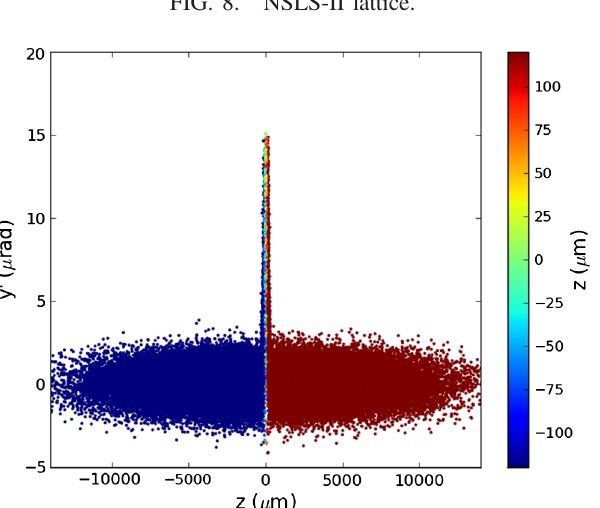
FIG. 8. NSLS-II lattice.